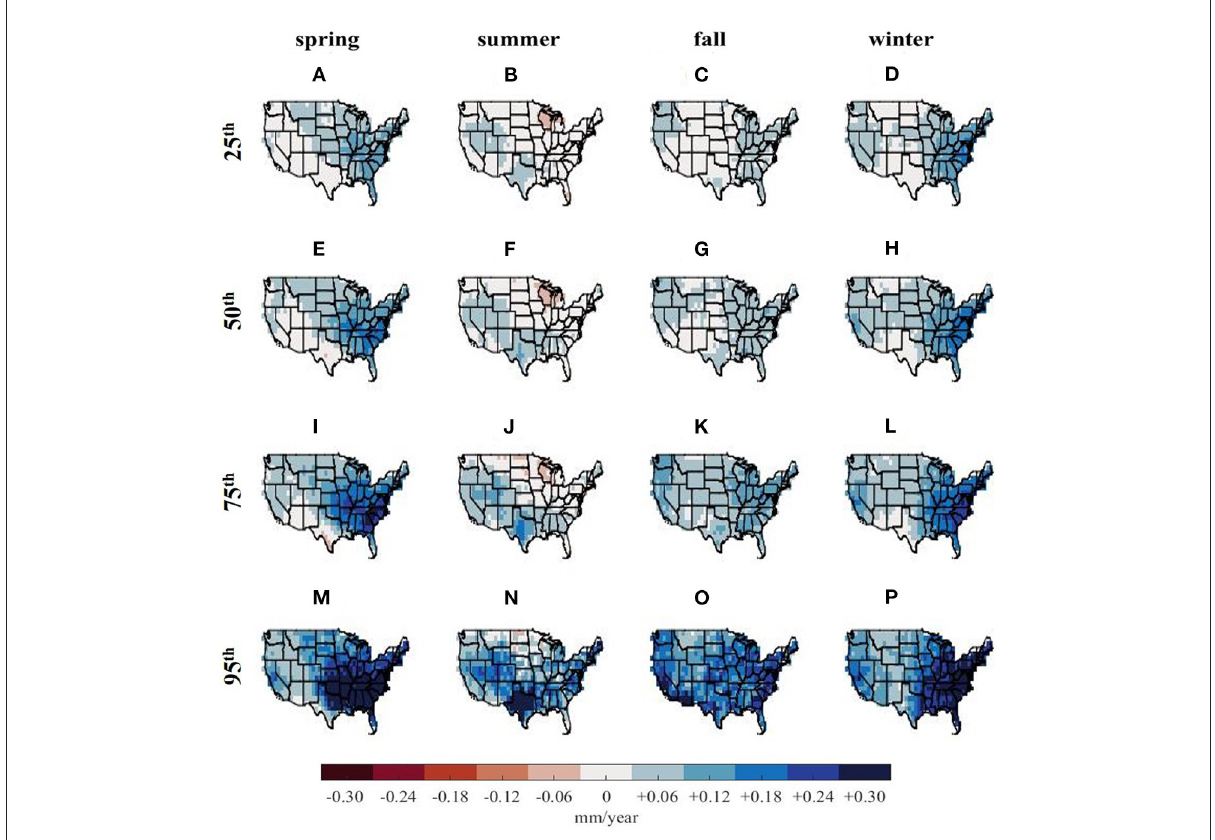
FIGURE2 CONUS spatial distribution of projected daily maximum (mm) Sen’s long-term trends of projected daily maximum precipitation (mm/year) from 2015 to 2100 using CESM2-LE for different quantiles (rows) across seasons (columns). Cold (blue) colors represent wetting trends, whereas warm (red) represents a drying trend, and no change is highlighted in the white color. The trend magnitudes are shown as; lower 25th [spring (A) , summer (B) , fall (C) , and winter (D) ; median 50th, (E–H) ; above median 75th, (I–L) ; and extreme 95th (M–P) ]. The cold (blue) color represents wetting trends, whereas warm (red) represents drying and no change is highlighted in white color. Single emission scenario SSP3 - 7.0 (between the moderate SSP4 - 6.0 and the worst-case SSP5 - 8.5 scenarios) is used in the